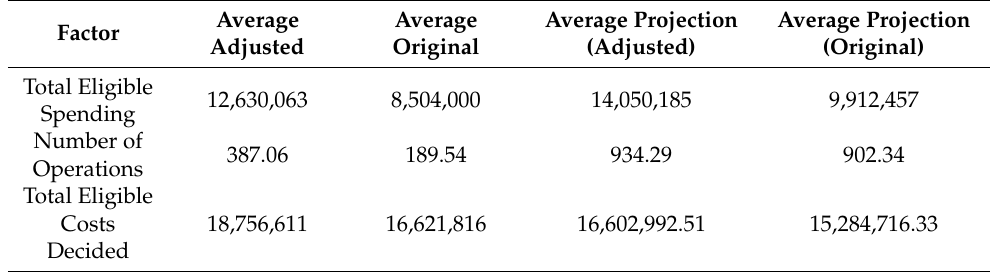
Table 14. Improvement potential for the OPs with and without adjusted